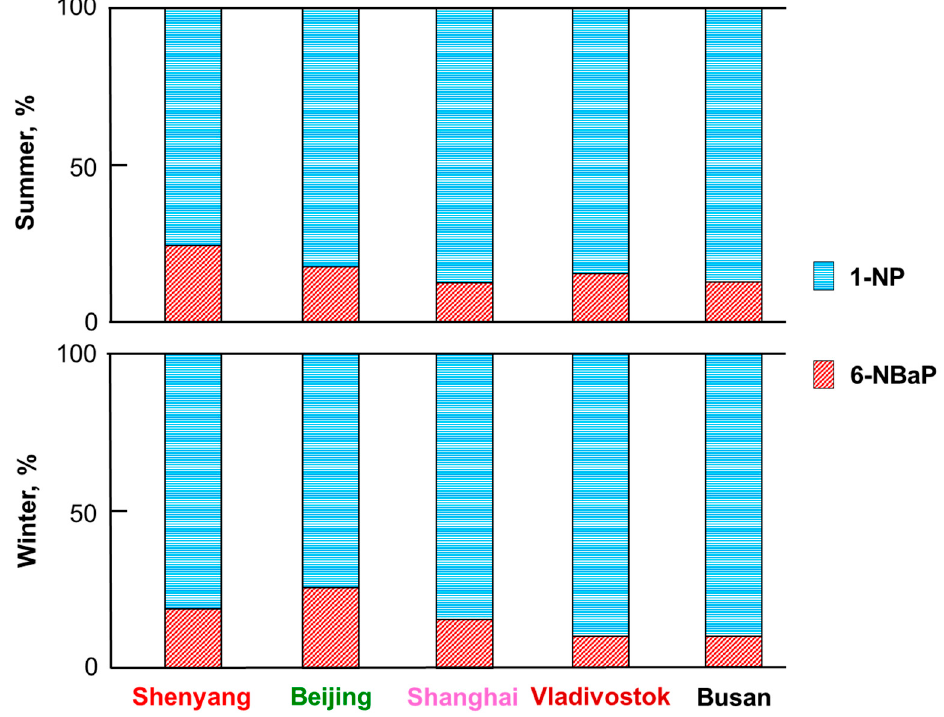
Figure 5. Composition of NPAHs in 2013/2014.